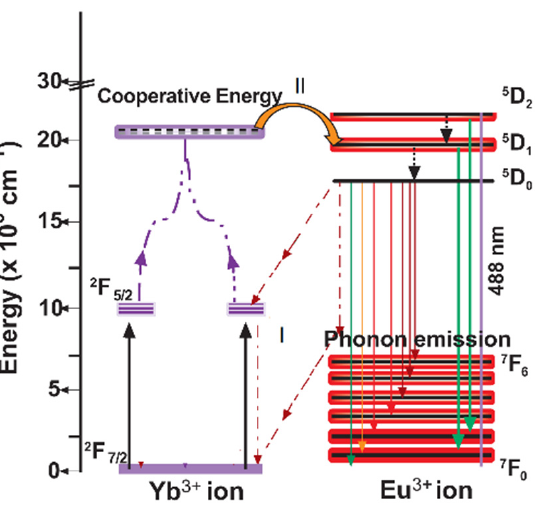
Figure 10. Energy level diagram for Eu 3+ /Yb 3+ co-doped ZnSe semiconductors showing activity transitions and ground state field splitting.